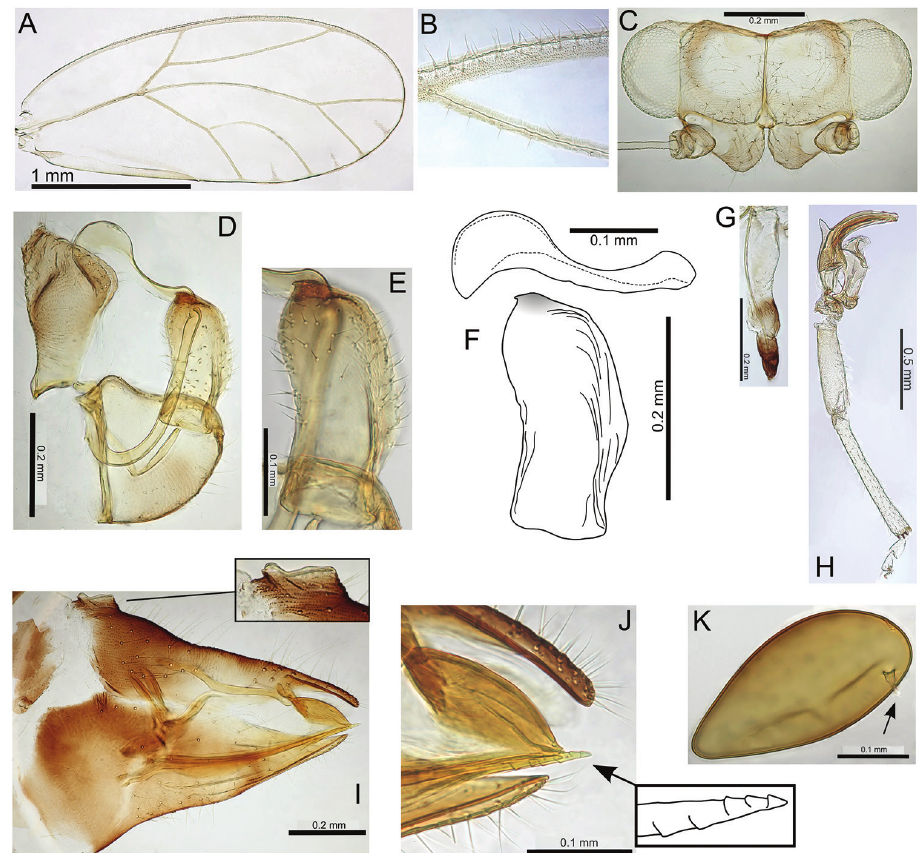
Figure 24. Pariaconus grandis sp. n. A fore wing B fore wing detail C head D male terminalia E para- mere F aedeagus and paramere G proboscis H hind leg I female terminalia showing raised anal ring collar (inset) J ovipositor (serrations indicated) K egg (pedicel